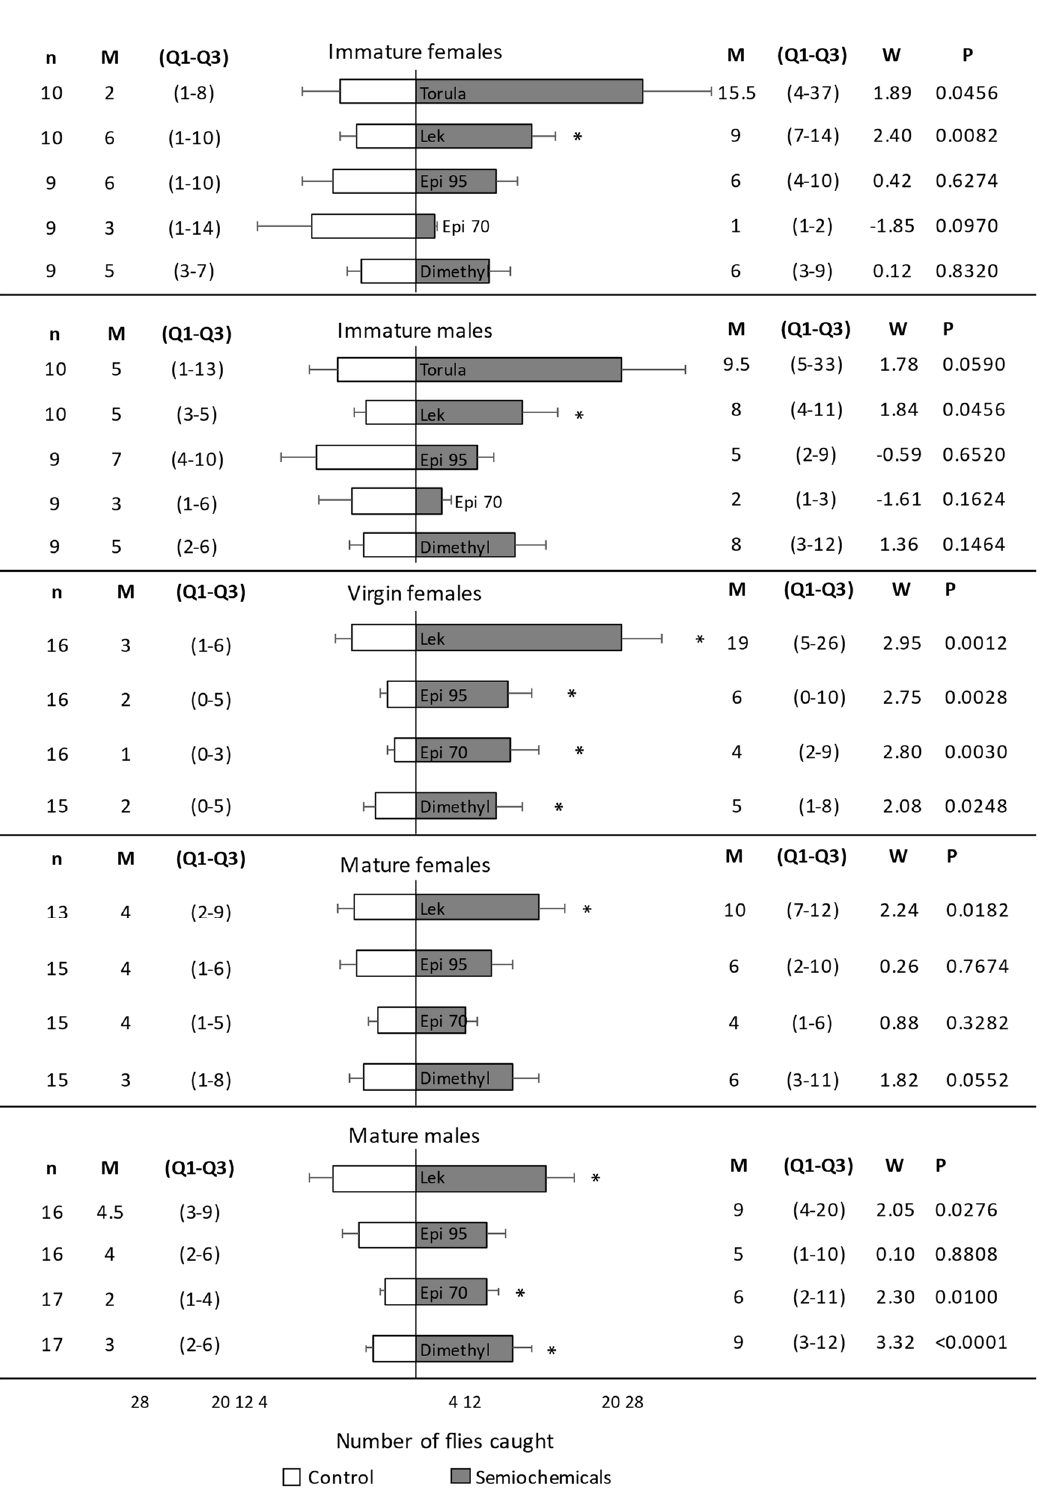
Figure 3. Number of Anastrepha fraterculus caught in traps with or without the stimulus under field cage experiments. Immature flies, mature-virgin females, and mature-mated flies were considered in separate experiments. Trans -tetrahydroactinidiolide (Dimethyl) and two epianastrephin-anastrephin formulations were considered: 95 wt.% epianastrephin (Epi 95) and 70 wt.% epianastrephin (Epi 70). Bars denote mean values (+SE). N (number of cages evaluated with 100 flies each), Median (M), Q1–Q3, and statistical values (W and p ) are also included on the figure sides. Asterisks denote significant differences (Wilcoxon